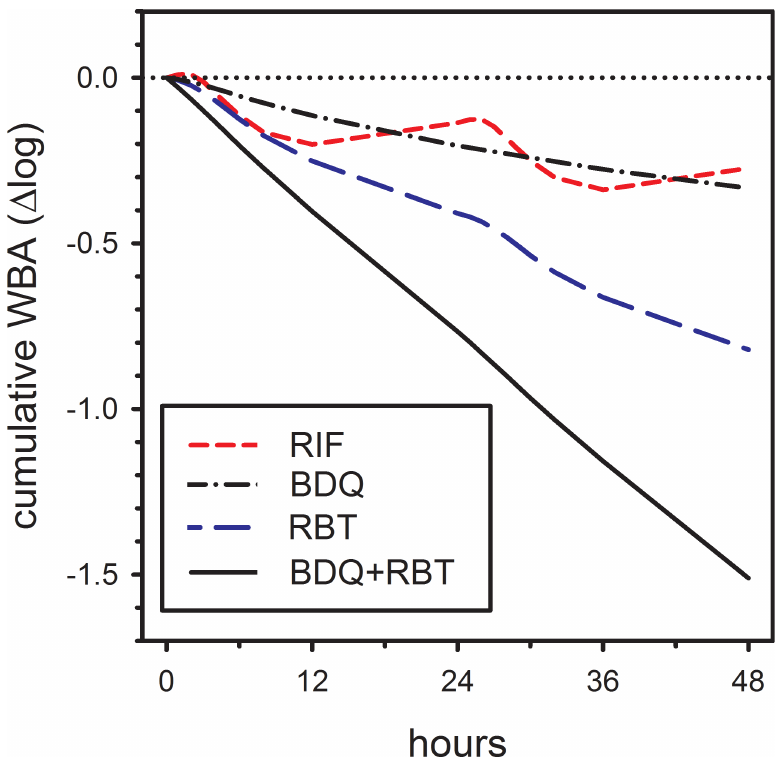
Fig 6. Predicted cumulative whole blood bactericidal activity (WBA) of bedaquiline, rifampin, rifabutin, and the combination of bedaquiline plus rifabutin, based on expected plasma concentrations in vivo during TB treatment, and observed more-than-additive